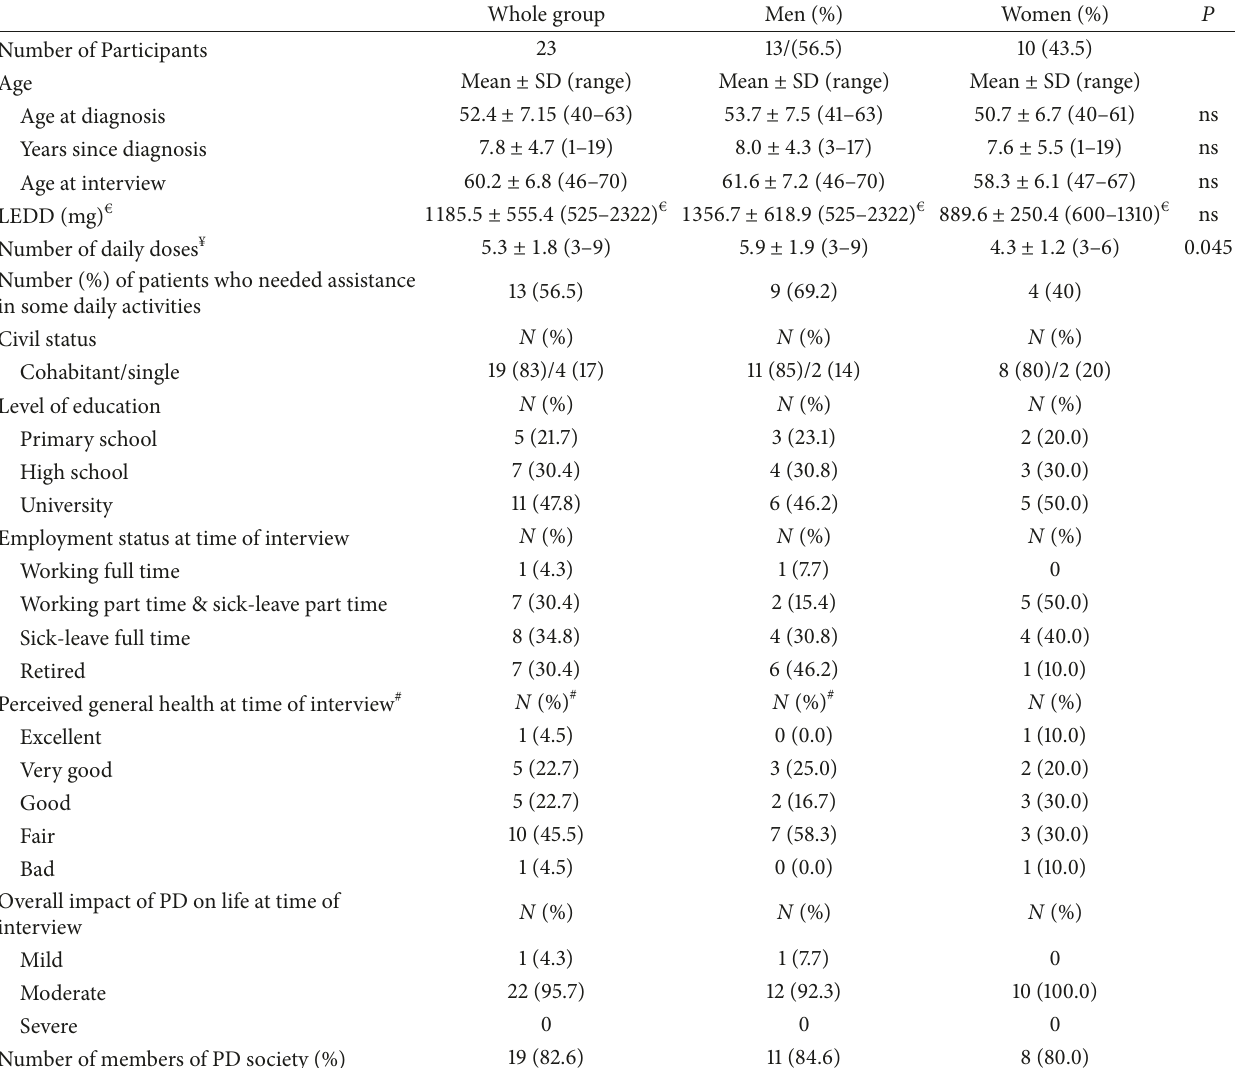
Table 1: Sociodemographic and clinical characteristics of 23 participants (10 women) with Parkinson’s